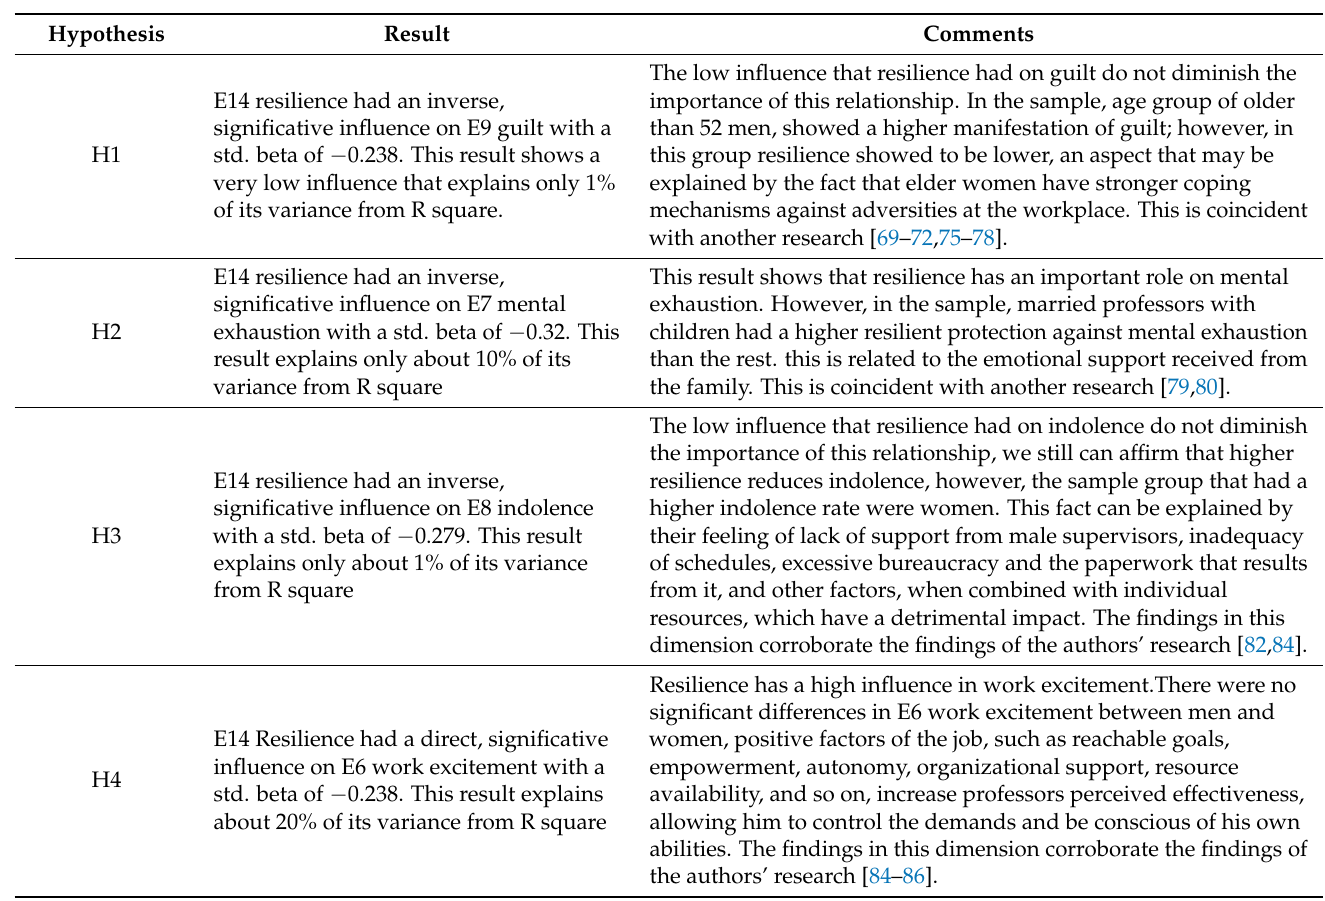
Table 6. Hypotheses results